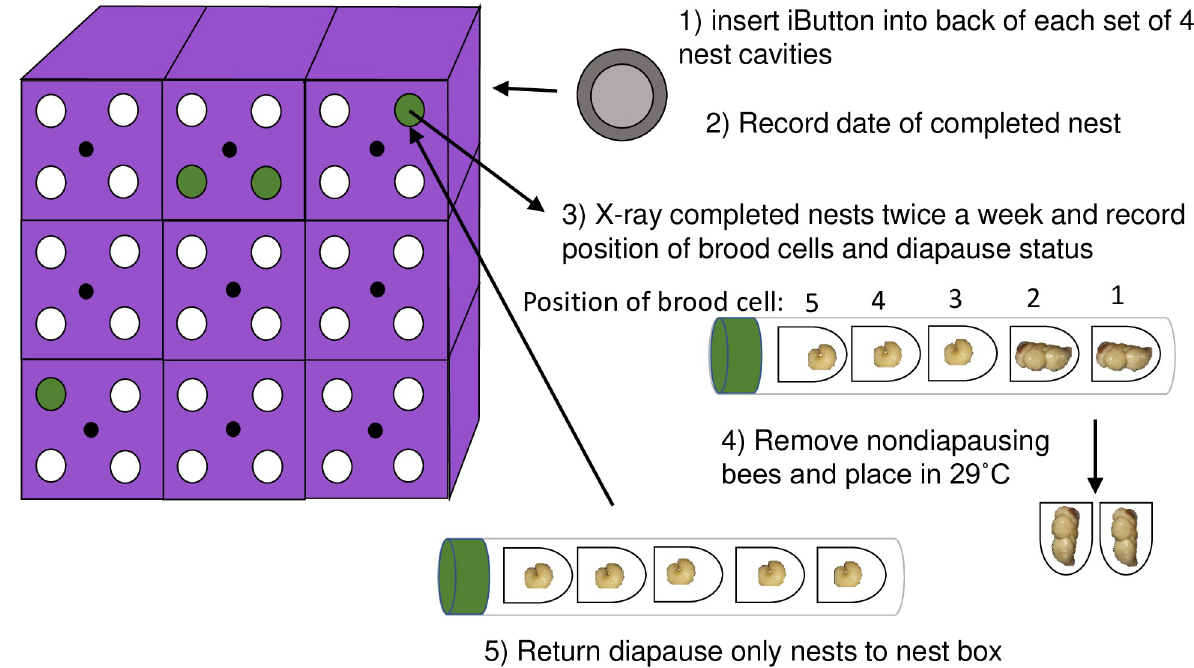
Fig 1. Experimental design. A nest box was constructed of 3D printed plastic blocks, each with four cavities. (1) The temperature of each block was recorded throughout the season using iButtons. (2) Nests were checked daily for completion. (3) Nests were X-rayed to determine diapause status, and (4) nondiapausing individuals were removed from the field and allowed to emerge in the lab. (5) Diapausing individuals were returned to the nest box and experienced field temperatures until September 22 nd (photo credit: Manitoba Department of